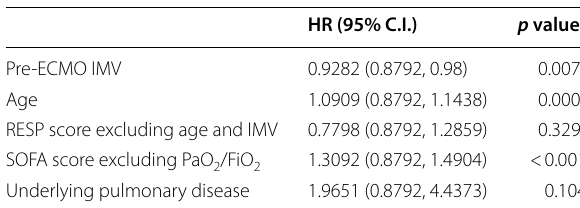
Table 5 Hazard ratios with confidence intervals from a Cox regression model with all